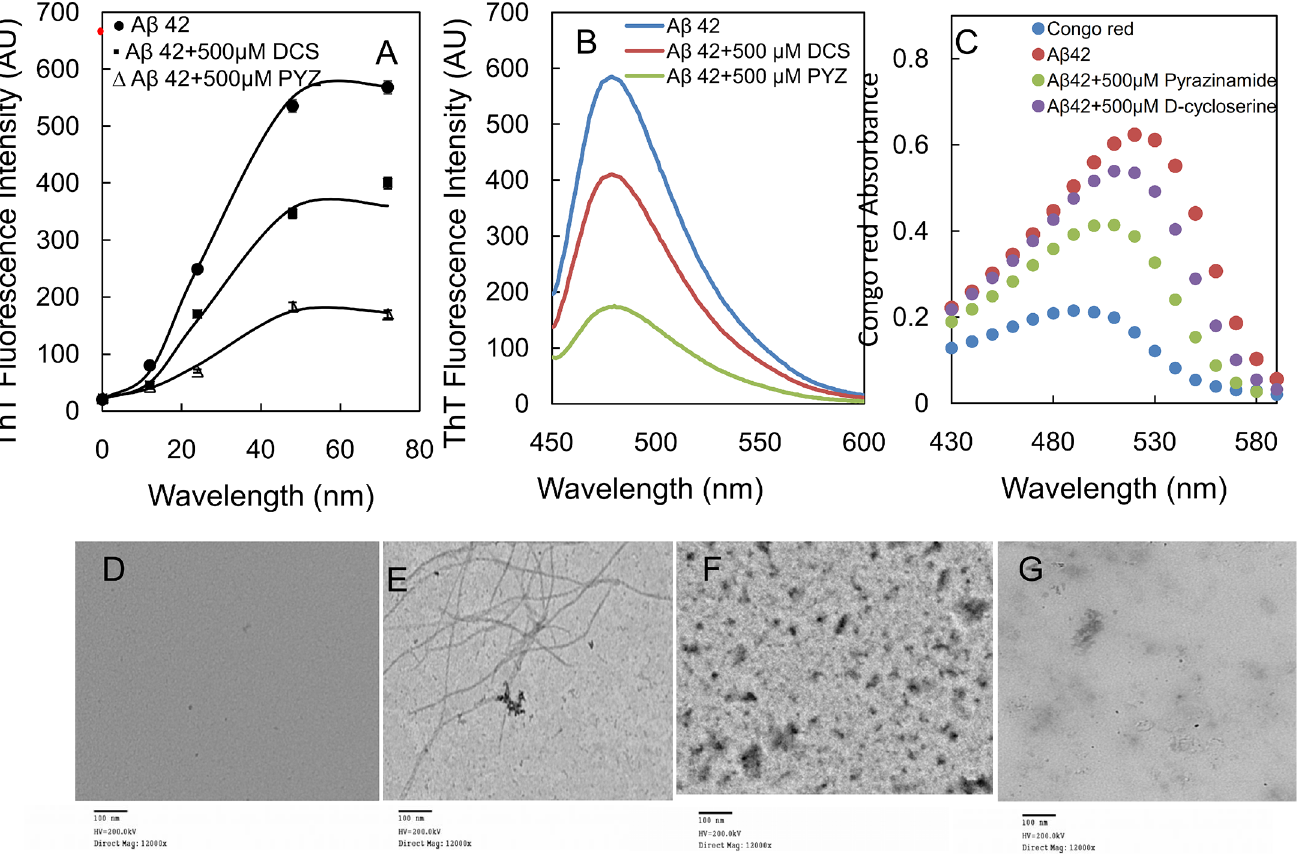
Fig 11. (A) ThT fluorescence kinetics measurements of A β -42when incubated at 37°C over a period of 70 h in absence and in presence of 500 μ M each of PYZ and DCS (B) ThT fluorescence spectra of A β -42 after incubation at 37°C for 70 h in absence and in presence of 500 μ M each of PYZ and DCS (C)Congo red absorption spectrum of A β -42after incubation at 37°C for 70 h in absence and in presence of 500 μ M each of PYZ and DCS, (D) TEM imageof A β -42 (E)TEM imageof A β -42 incubated at 37°C for 70 h (F) TEM imageof A β -42 incubated at 37°C for 70 h in presence of 500 μ M PYZ (G) TEM imageof A β -42 incubated at 37°C for 70 h in presence of 500 μ M DCS.